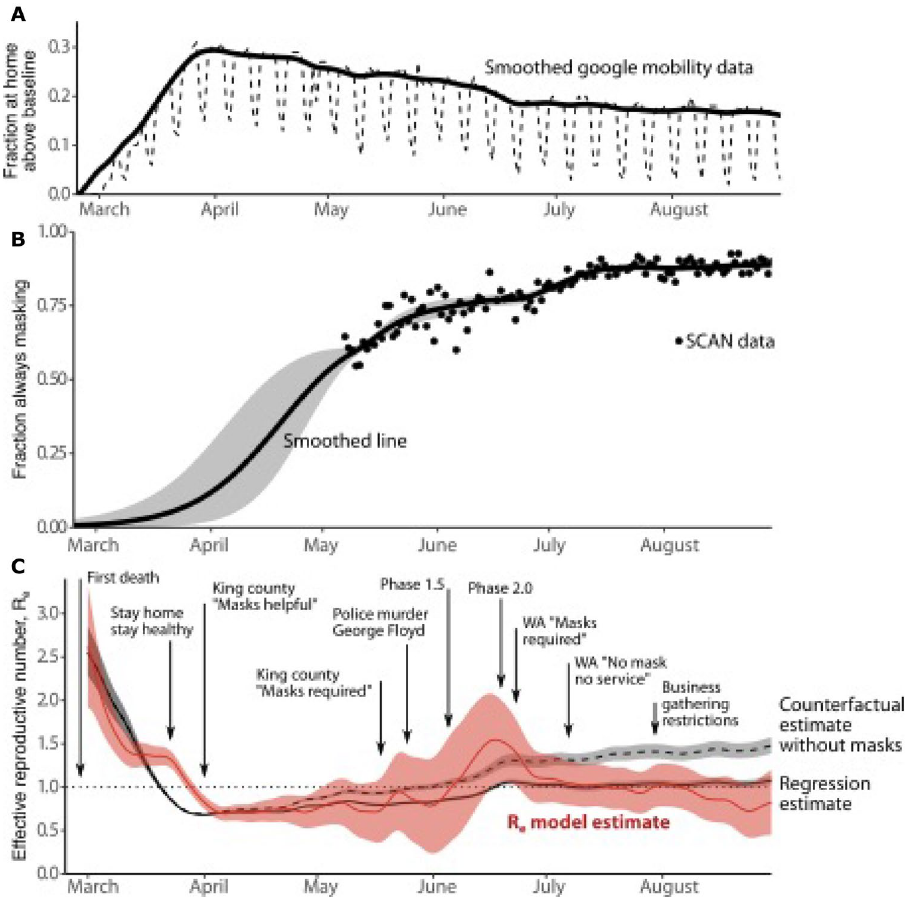
Figure 6. Empirical estimated impact of mask usage in King County, Washington. Regression model estimates of reduction in effective reproductive number (R e ) explained by human mobility and mask wearing. ( A ) Percent of devices at home above baseline using smoothed Google mobility data between March and August 2020. ( B ) From the greater Seattle Coronavirus Assessment Network (SCAN), fraction self-reporting they always wear a mask when in public. Data and best fit line with associated 95% confidence interval (CI). ( C ) Estimated R e from epidemiological data (red), modeled reduction in R e due to reduced mobility and masking (solid black), and counterfactual scenario without masks (dashed black). Each line is bounded by 95% CI. Dates marking important events and local policy changes that affected gathering behavior and masking are